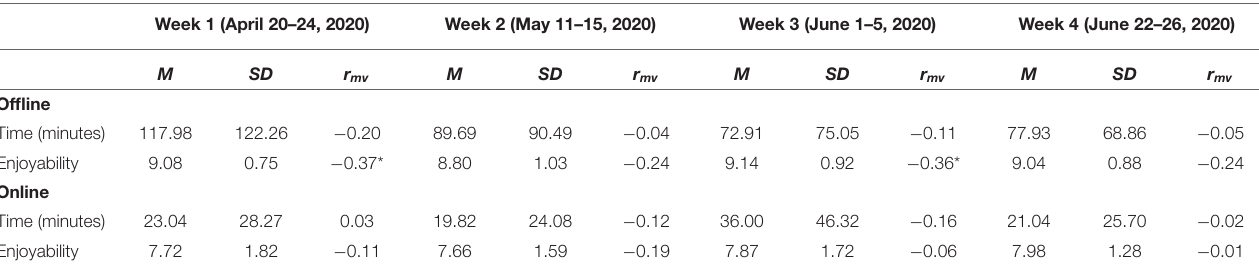
TABLE 3 | Means, standard deviations and correlations with mood variability of time and grade of offline and online peer contact during the different assessment